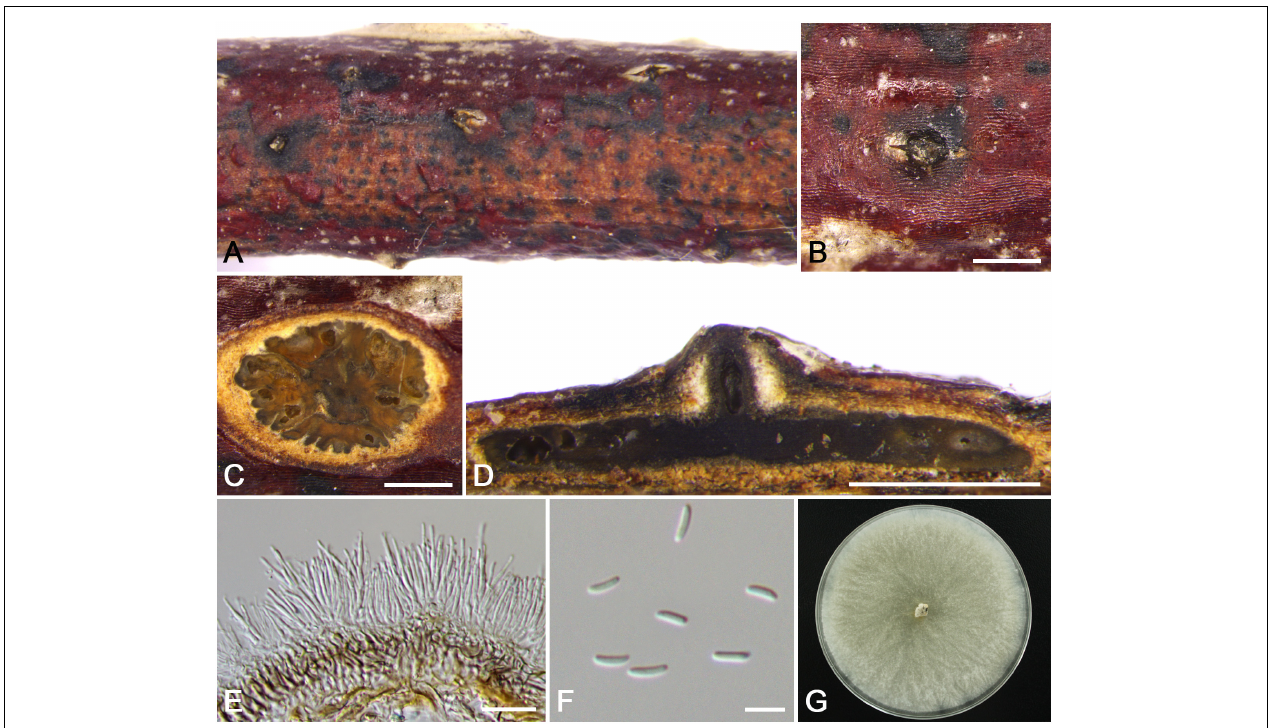
FIGURE 14 | Morphology of Cytospora xinjiangensis from Rosa sp. (CF 20197520). (A,B) Habit of conidiomata on twig. (C) Transverse section of conidioma. (D) Longitudinal section through conidioma. (E) Conidiophores and conidiogenous cells. (F) Conidia. (G) Colonies on PDA for 2 weeks. Bars: (B–D) = 500 µ m; (E) = 10 µ m; (F) = 5 µ